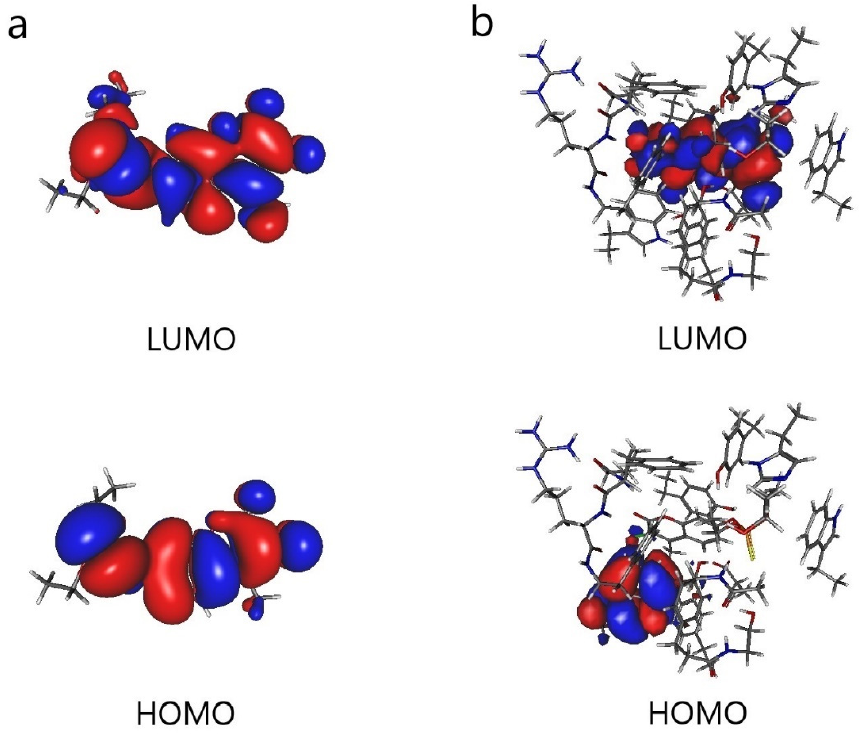
Figure 5. Frontier molecular orbitals (HOMO and LUMO): ( a ) coumaphos ( Cou ) and ( b ) AChE cluster model with coumaphos (AChE_1_ Cou ).